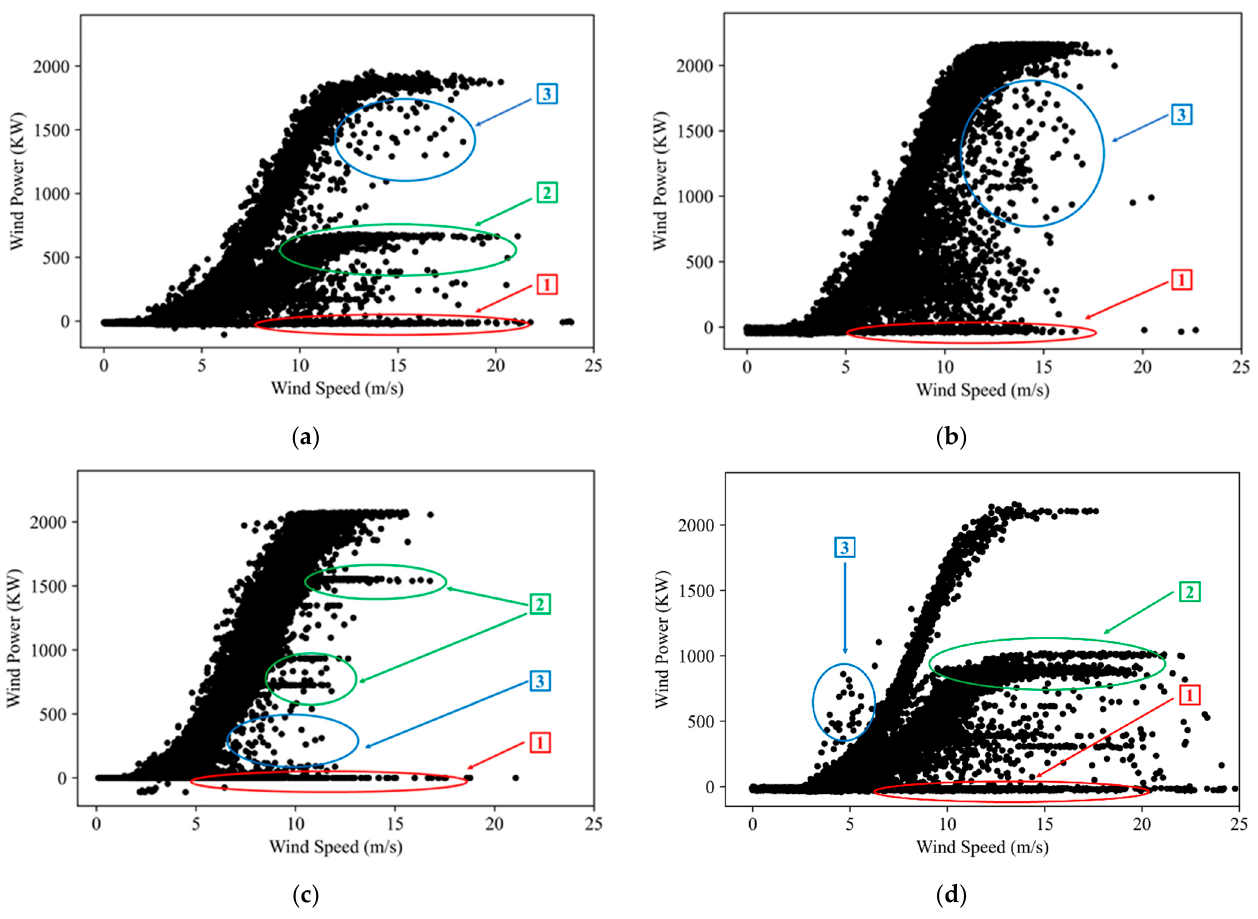
Figure 1. Wind power curves of four wind turbines: ( a ) No. 3, ( b ) No. 4, ( c ) No. 5, ( d ) No. 6.